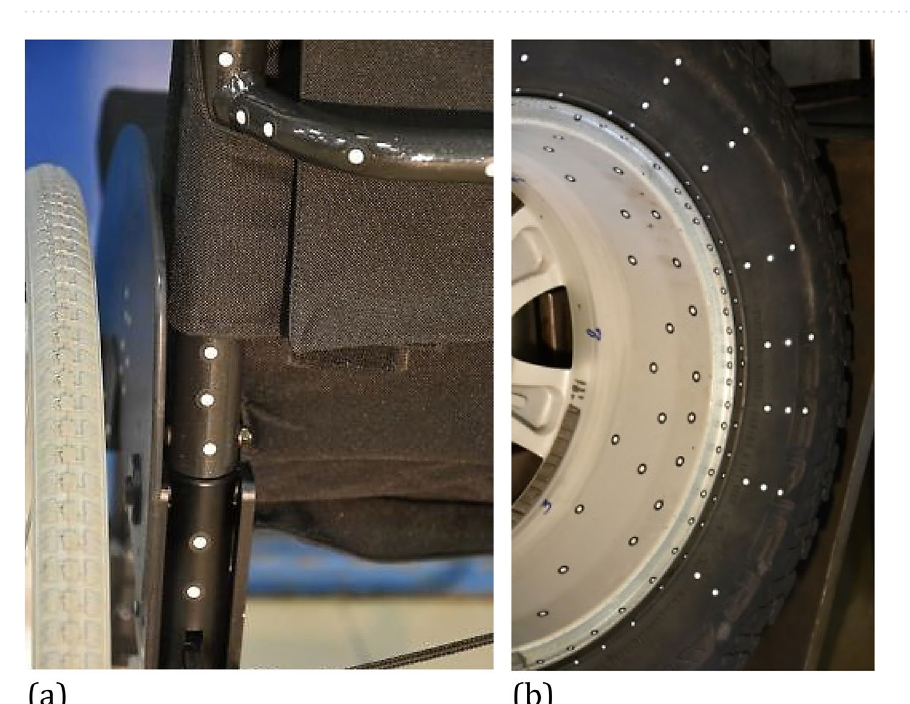
Figure 2. Distribution of markers on selected components of the wheelchair ( a ) and entire wheel ( b ) tested using a PONTOS 5 M DIC